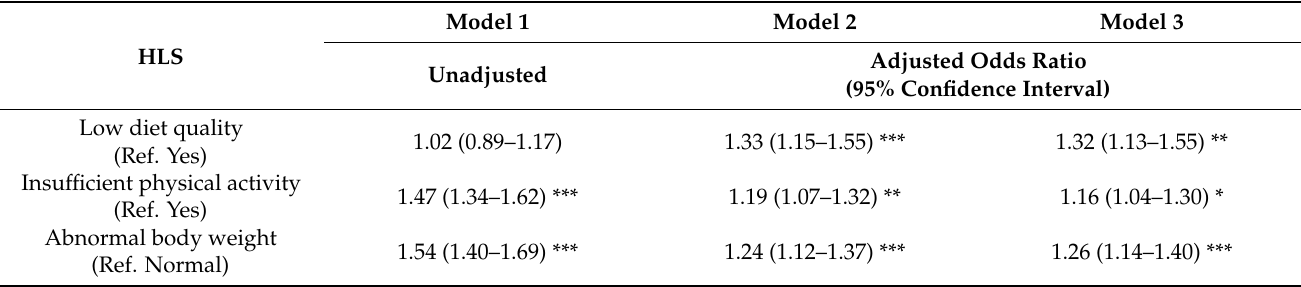
Table 3. Multivariable association between HLS and periodontal diseases.